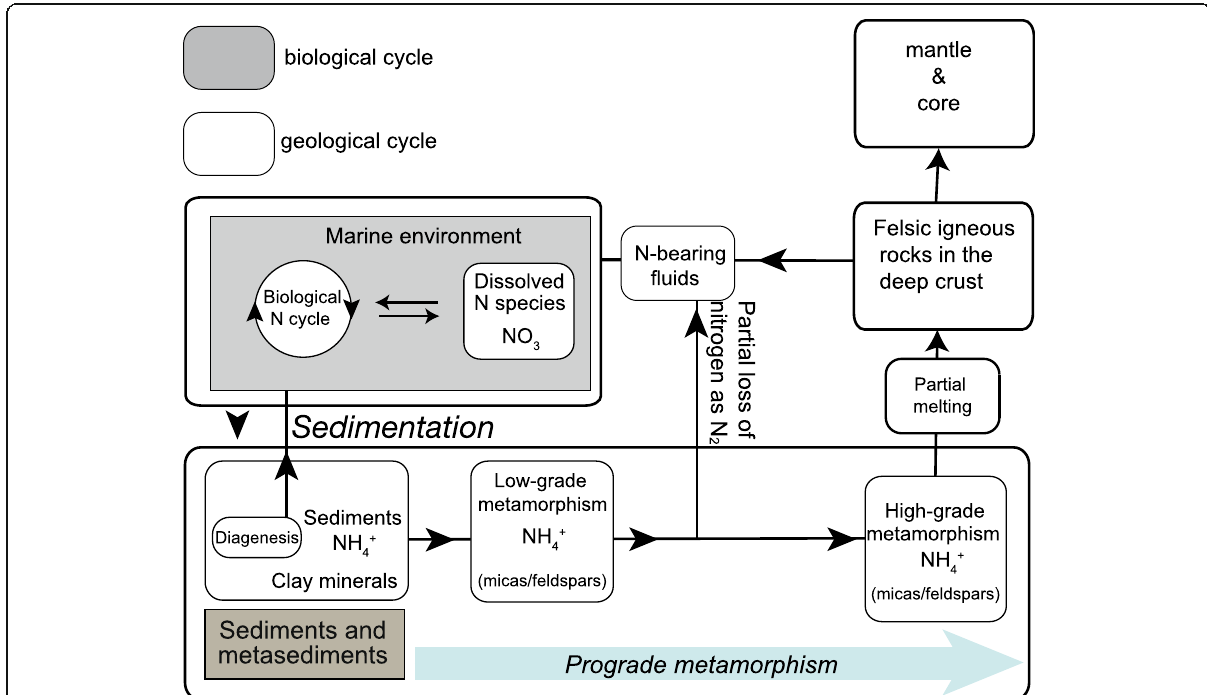
Fig. 1 Simplified schematic representation of integrated geologic and biologic recycling schemes of nitrogen in the Earth ’ s crust (modified from Bebout et al. 2013)